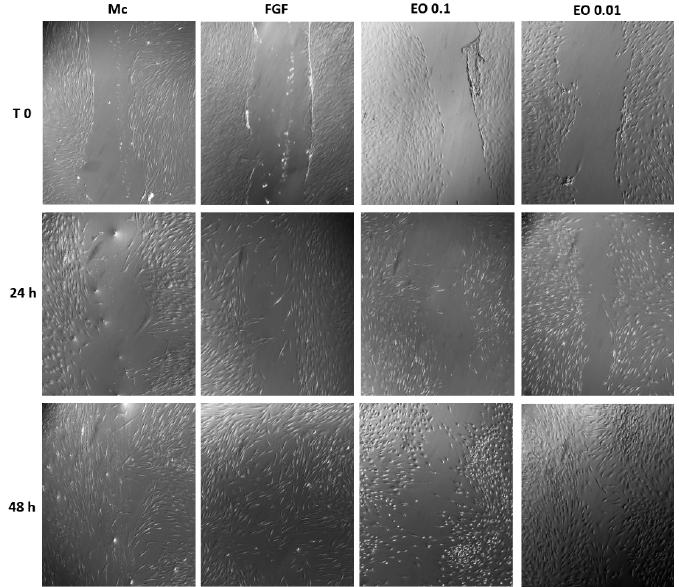
Figure 10. Cell migration test. A wound was simulated in the center of the cell monolayer and then the stimuli were applied: M: supplemented DMEM; FGF: fibroblast growth factor; EO: 0.1 and 0.01 mg/mL. The photographs corresponded to time 0 (immediately after inflicting the wound) at 24 h and 48 h after the application of stimuli.